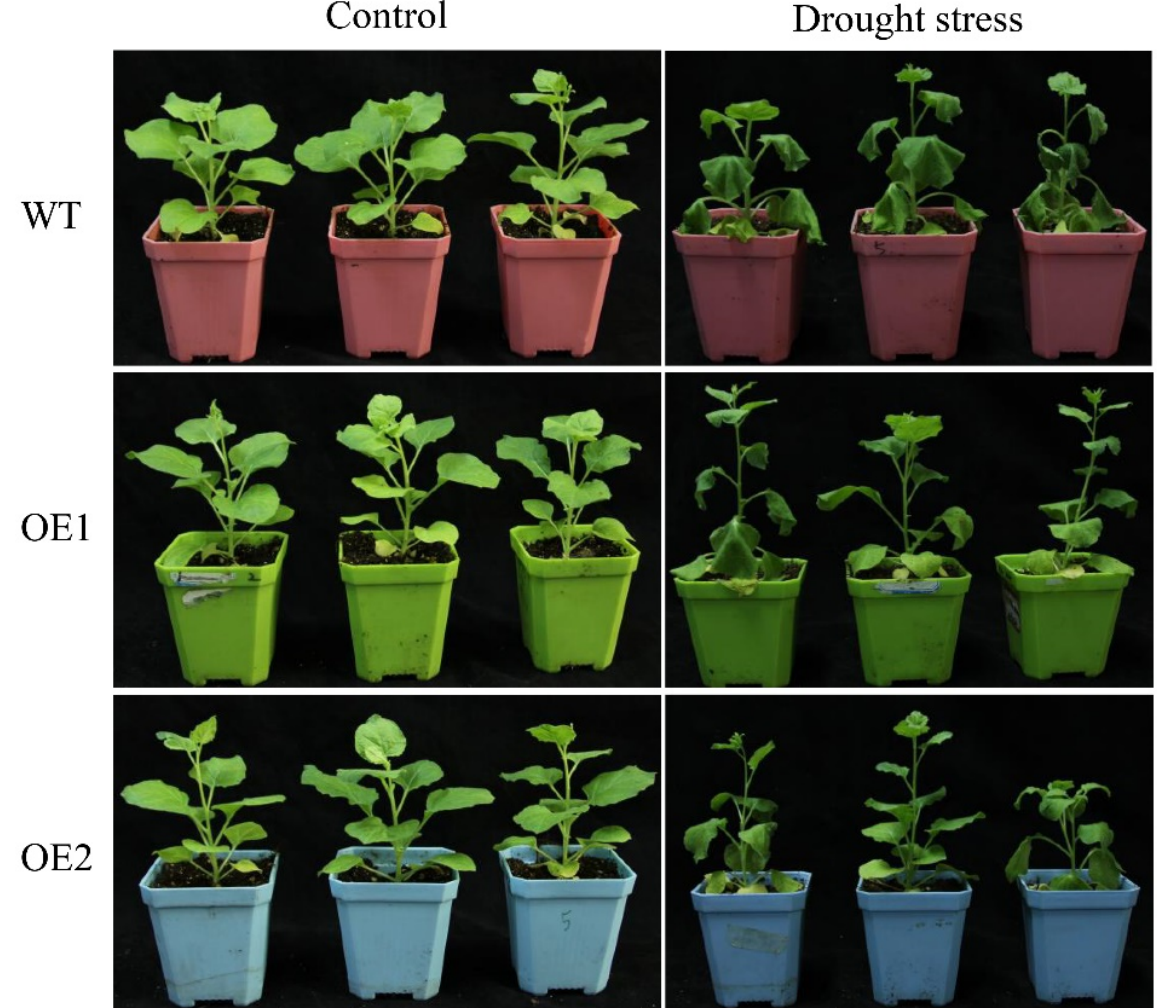
Figure 6. Phenotypes of transgenic Nicotiana benthamiana plants overexpressed sugarcane ScDREB2B-1 under drought stress for 2 d. WT: wild-type N. benthamiana . OE1 and OE2: different transgenic N. benthamiana lines overexpressed ScDREB2B-1 .